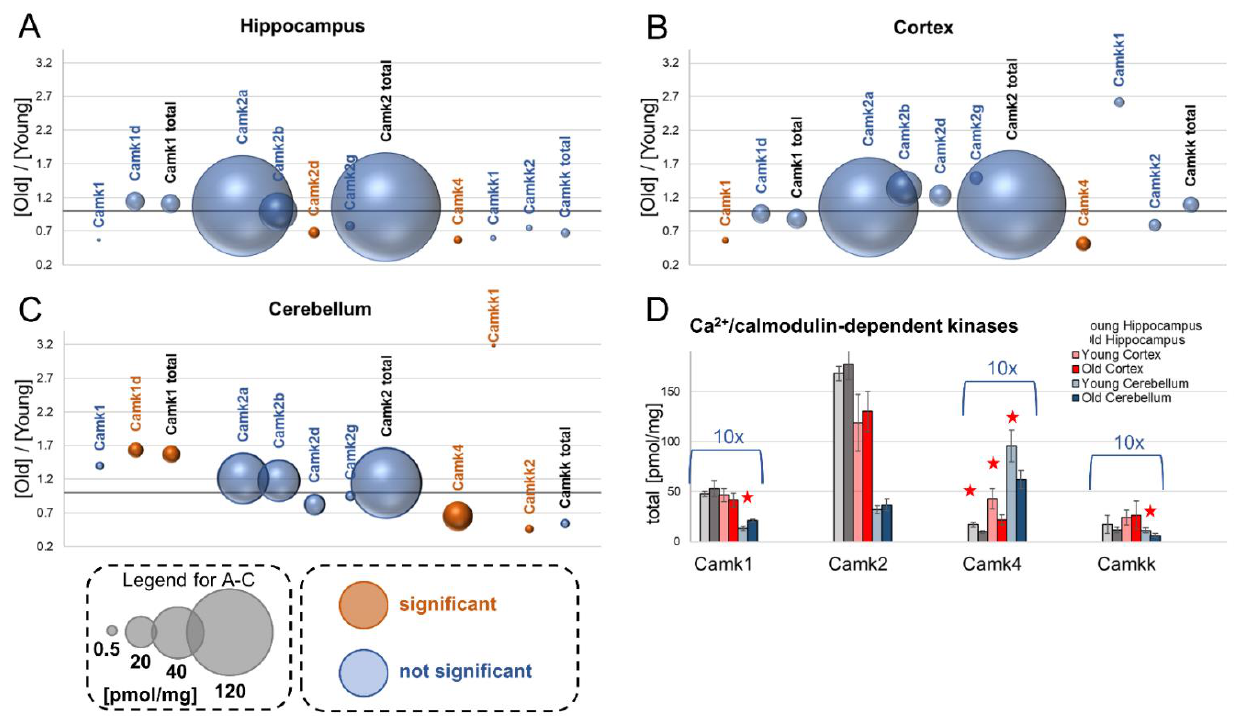
Figure 3. The effect of aging on calcium/calmodulin-dependent kinases. The ratios of protein titers in old vs. young brain structures in: hippocampus ( A ), cortex ( B ) and cerebellum ( C ). Total concentrations of the kinase families in young and old animals are shown in ( D ) (* p < 0.05). The size of bubbles is proportional to the average protein concentration in the respective old brain structures. Statistically significant differences are shown as the red bubbles.